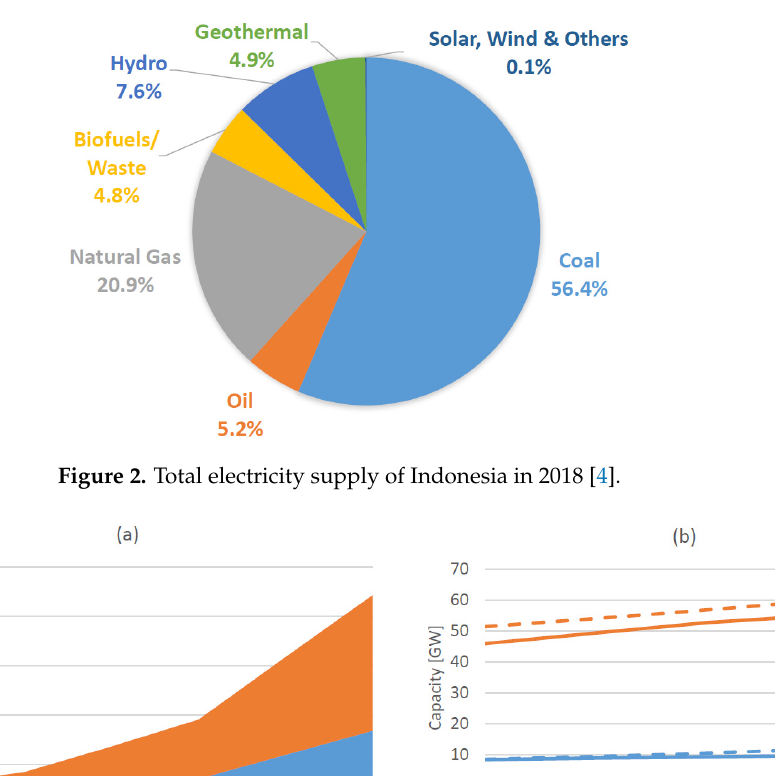
Figure 2. Total electricity supply of Indonesia in 2018 [4]. Table 2. The levelized cost of electricity of renewables and fossil-fuelled generators in Indonesia. Values for OTEC based on [20], values for all other technologies based on [21].